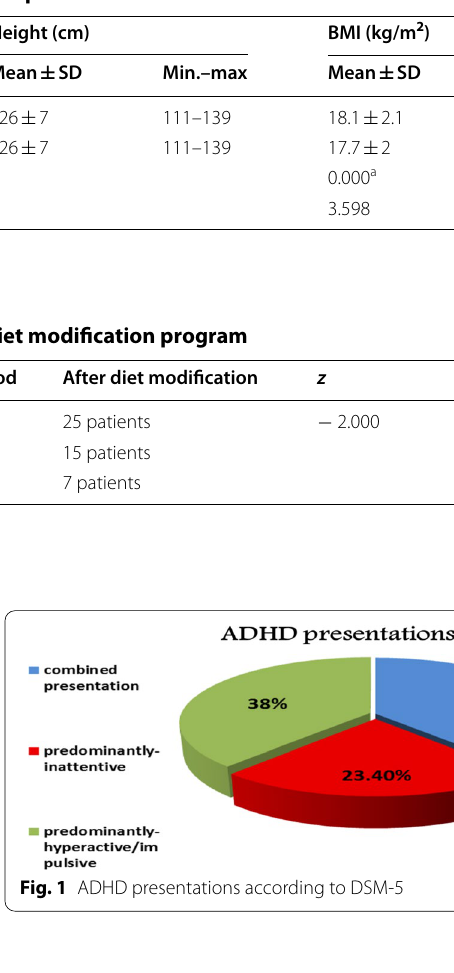
Table 1 Anthropometric data of studied sample during baseline period and after diet modification